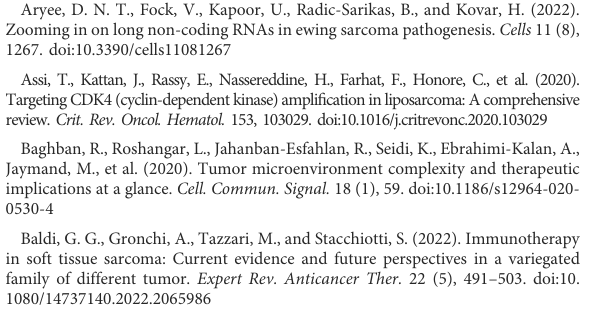
SUPPLEMENTARY FIGURE S1 Validation of the CuLncScore Model and the Cuproptosis LncRNA ClustersfortheTARGETCohort. (A) Overallsurvivaldifferencesbetween high and low-risk groups in the TARGET-Osteosarcoma cohort. (B) Overall survival differences between four cuproptosis lncRNA clusters in the TARGET-Osteosarcoma cohort. SUPPLEMENTARY FIGURE S2 Biological features of 4 Cuproptosis LncRNA Clusters. GO enrichment analysis in the C1 group, (A) C2 group (B) , C3 group (C) , and C4 group (D) . KEGG pathway enrichment analysis in the C1 group (E) , C2 group (F) , C3 group (G) , and C4 group (H)